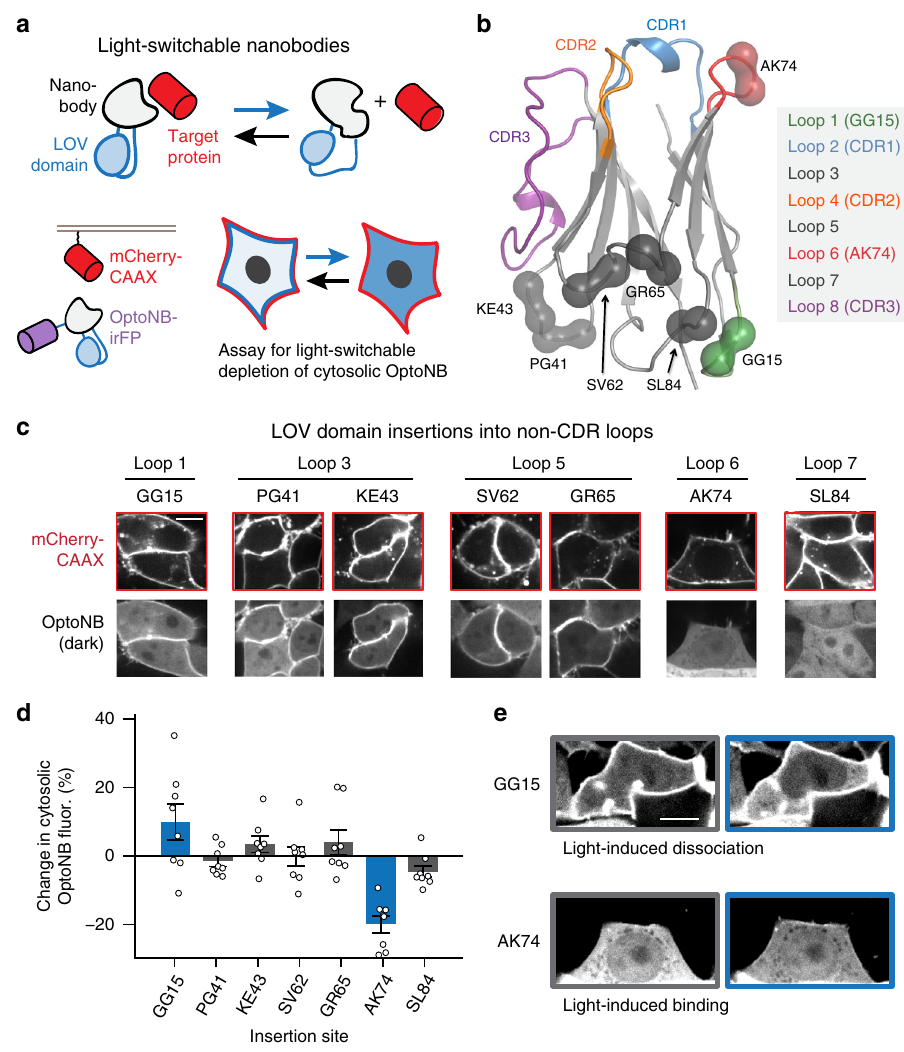
Fig. 1 Initial screen for light-controllable opto-nanobodies (OptoNBs). a Schematic of approach. By insertion into a solvent-exposed turn or loop, the light-switchable AsLOV2 domain (blue) could modulate the conformation of a nanobody (gray), thus allosterically altering its ability to bind to a target protein (red). Cytosolic iRFP-fused OptoNBs were assayed for translocation to membrane-bound mCherry in the presence or absence of blue light. b Positions targeted for LOV domain insertions mapped onto the crystal structure of an anti-GFP minimizer nanobody (PDB ID: 3G9A). Spheres indicate the residues between which the LOV domain was inserted. Loops of interest and the hypervariable complementarity-determining regions (CDRs) are colored according to the legend. c Representative images for all LOV insertions. HEK293 cells expressing membrane-tethered mCherry (mCherry-CAAX) and cytosolic OptoNB-iRFP (OptoNB) are shown. d Quanti fi cation of light-induced change in cytosolic intensity for each OptoNB variant in ( c ). An increase in cytosolic OptoNB fl uorescence corresponds to light-induced dissociation from membrane-bound mCherry, and vice versa for light-induced decrease in cytosolic iRFP. Error bars indicate mean ± SEM for n = 8 cells per variant. e Images before (gray box) and after (blue box) light stimulation for HEK293T cells expressing mCherry-CAAX and either of two OptoNB variants, LaM8-AK74 and LaM8-GG15, showing light-dependent changes in OptoNB localization. Images are representative of three replicate experiments. Scale bars: 10 μ m. Source data are available as a Source data fi